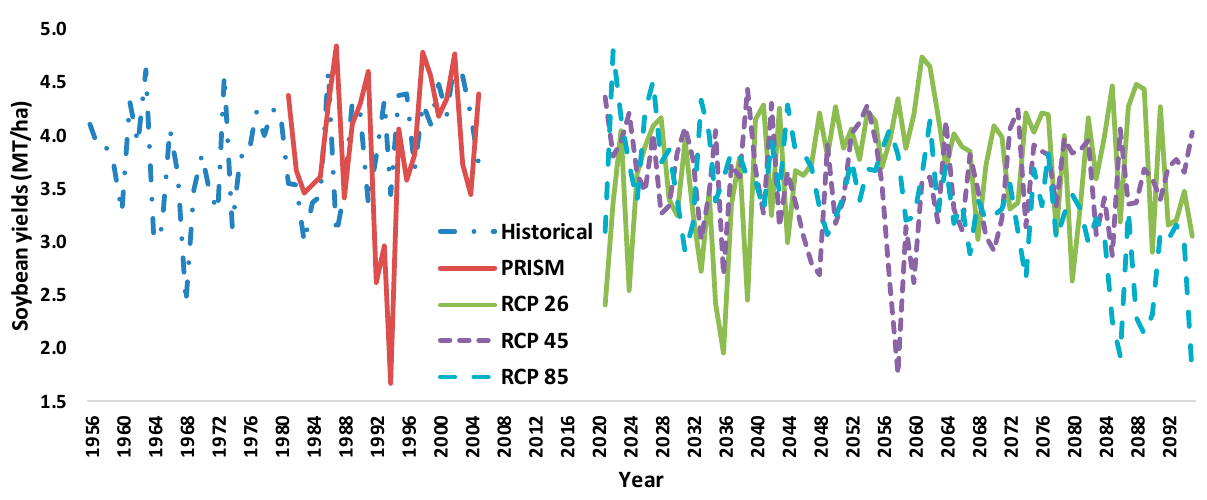
Figure 6. Graph of annual simulated soybean yields by climate scenario.